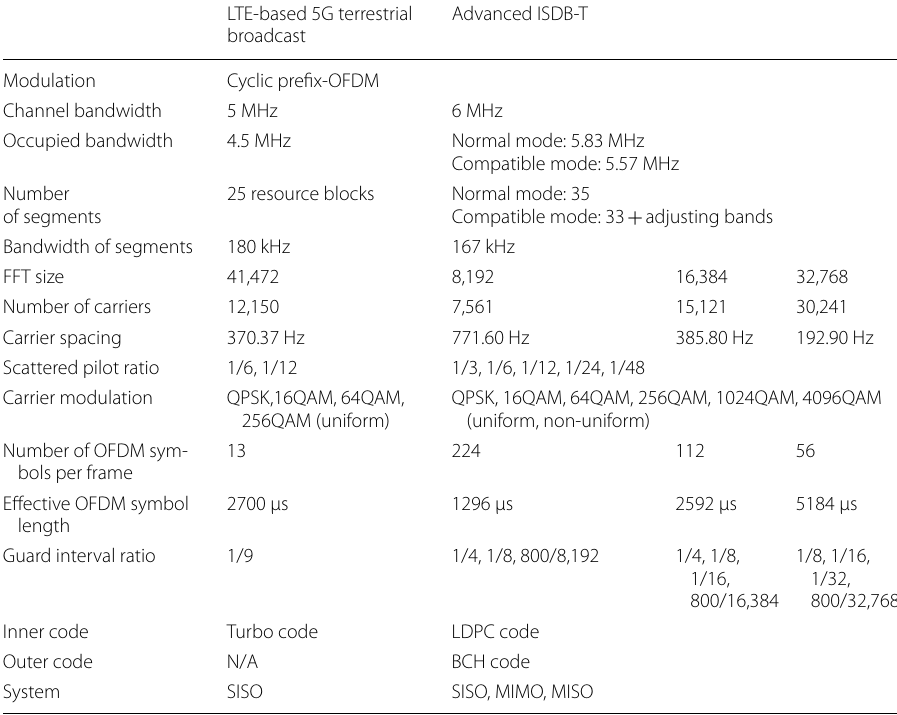
Table 1 Transmission parameters of LTE-based 5G terrestrial broadcast and advanced ISDB-T LTE-based 5G terrestrial Advanced broadcast